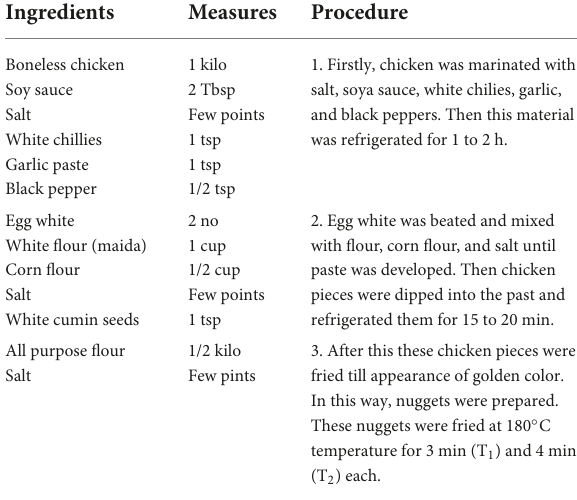
TABLE 8 Ingredients and procedure for preparation of chicken